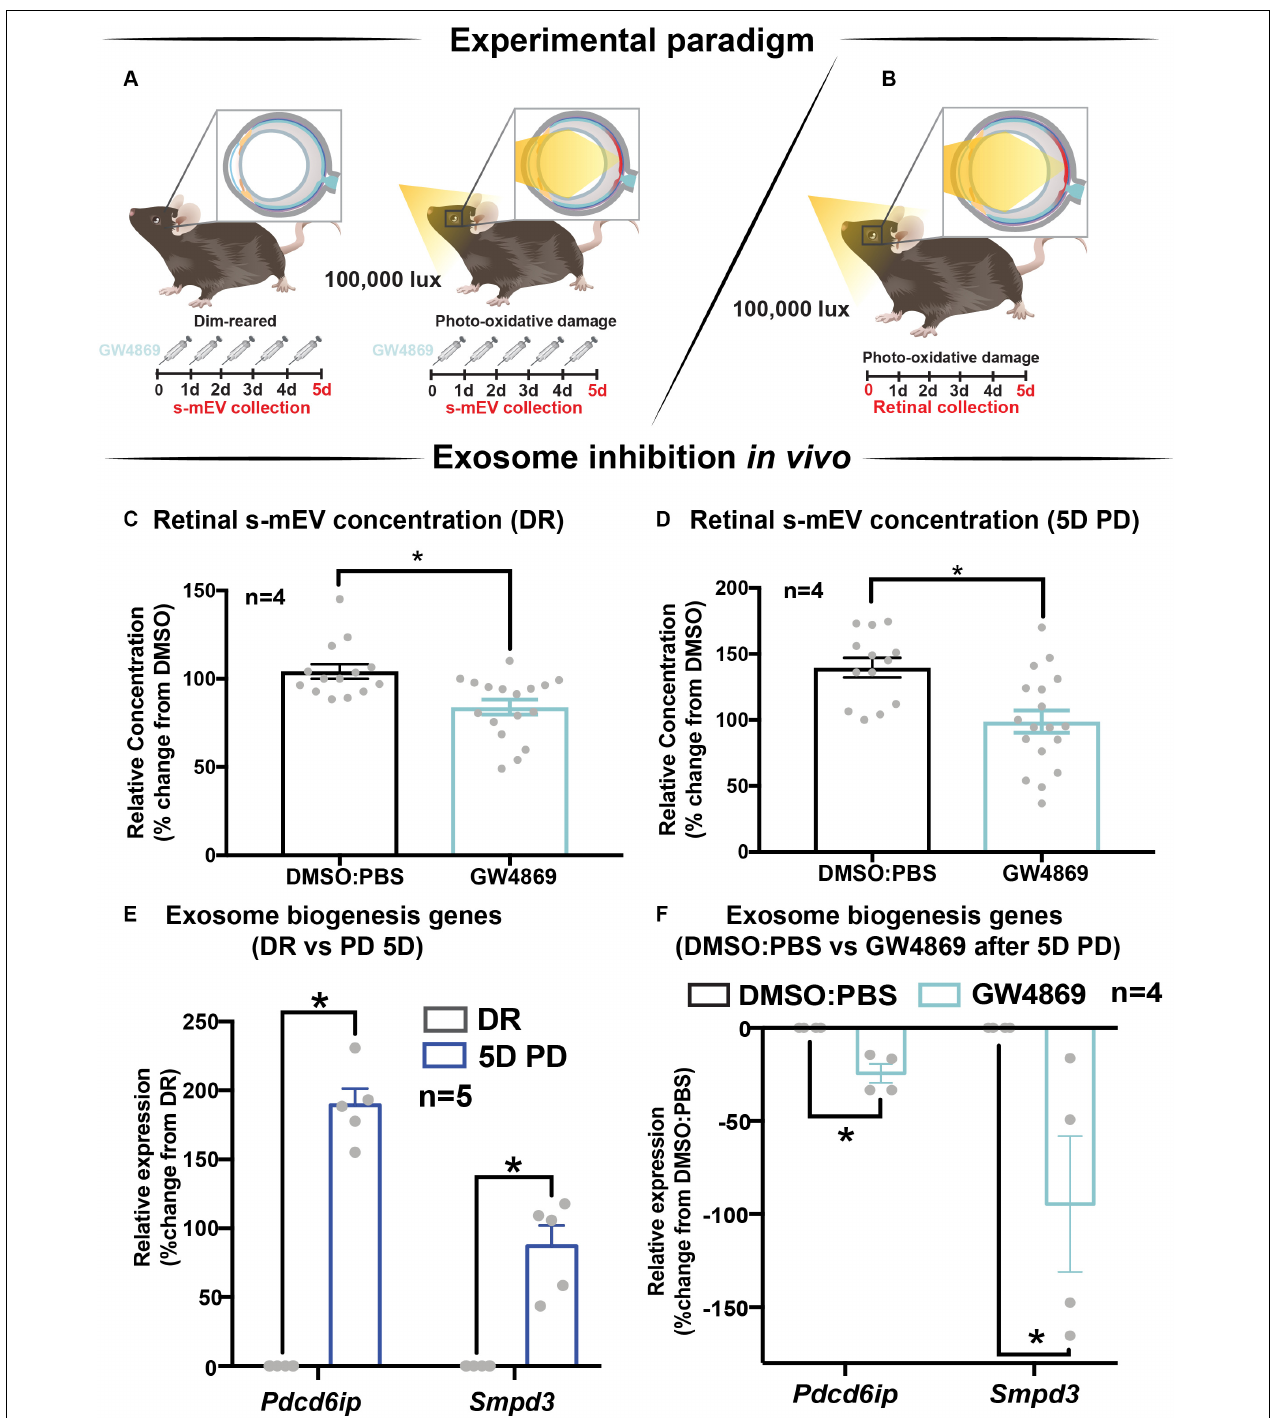
FIGURE 4 | GW4869 inhibits bioavailability of retinal s-mEV. (A,B) Experimental paradigm with red retinal labeling indicating lesion site. (C,D) Nanotracking analysis (NanoSight NS300) quantification revealed a significant reduction in the concentration of s-mEV isolated from both DR and 5D PD retinas following 5 daily intraperitoneal injections of GW4869 compared to respective DMSO controls ( P < 0.05, n = 4). The expression of exosome biogenesis genes Pdcd6ip and Smpd3 as measured by qRT-PCR was (E) significantly increased following 5D PD relative to DR controls ( P < 0.05, n = 5) and (F) significantly reduced following daily injections of GW4869 while undergoing 5D PD, relative to DMSO injected controls ( P < 0.05, n = 4). * denotes = P < 0.05.